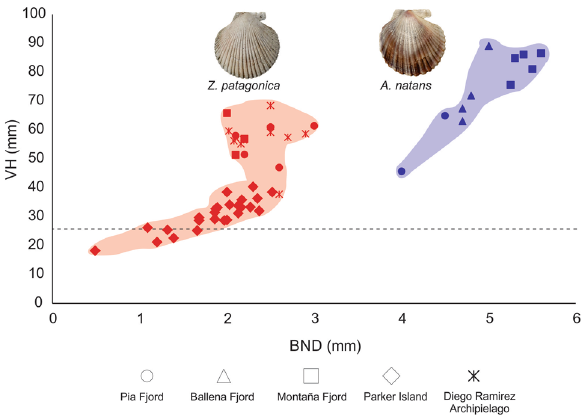
Figure 3. Bivariate plot of depth of byssal notch (BND) against valve height (VH) of individuals of Zygochlamys patagonica (in red) and Austrochlamys natans (in blue) collected in the MP.